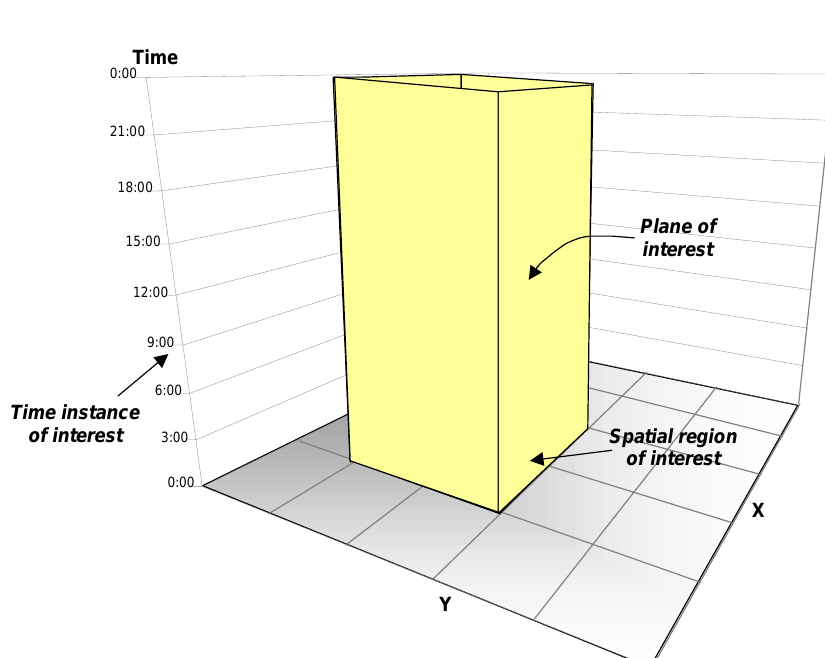
Figure 2. Plane of Interest from Time Instance of Interest and Spatial Division of Interest